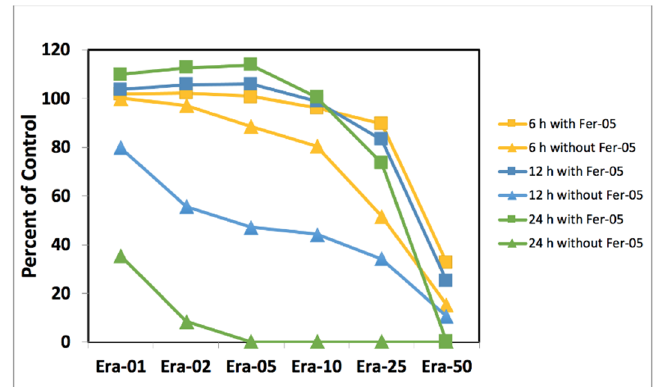
Figure 5. Cell death inhibition by without and with Fer-05 for Era-01, Era-02, Era-05, Era-10, Era-25, and Era-50 samples after 6-, 12-, and 24-h.